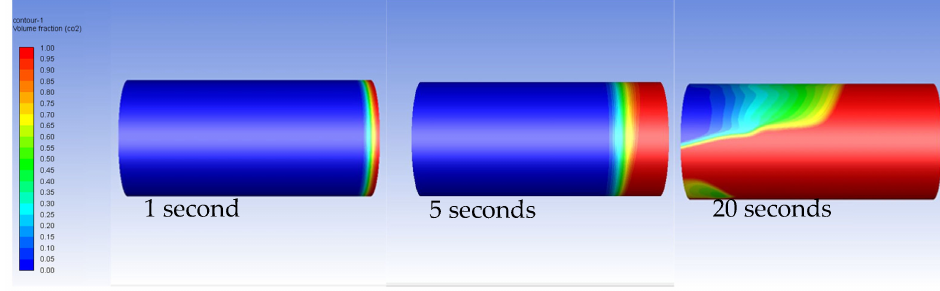
Figure 9. CO 2 volume fraction after 1 s, 5 s, and 20 s at inlet pressure of 2.6